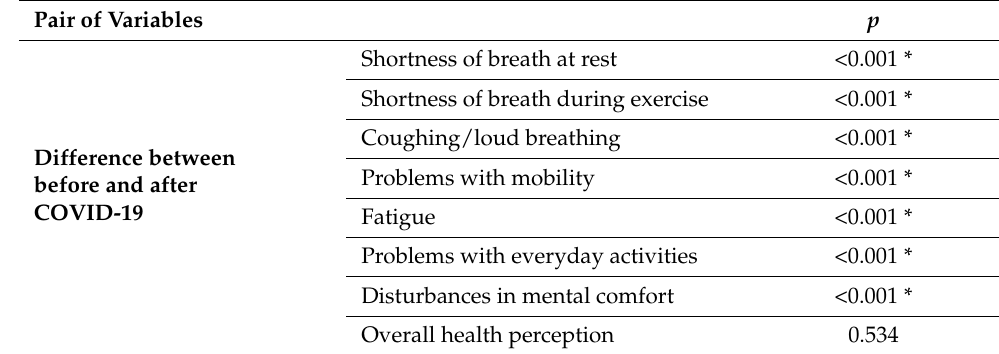
Table 6. Correlation of the severity of symptoms before and after